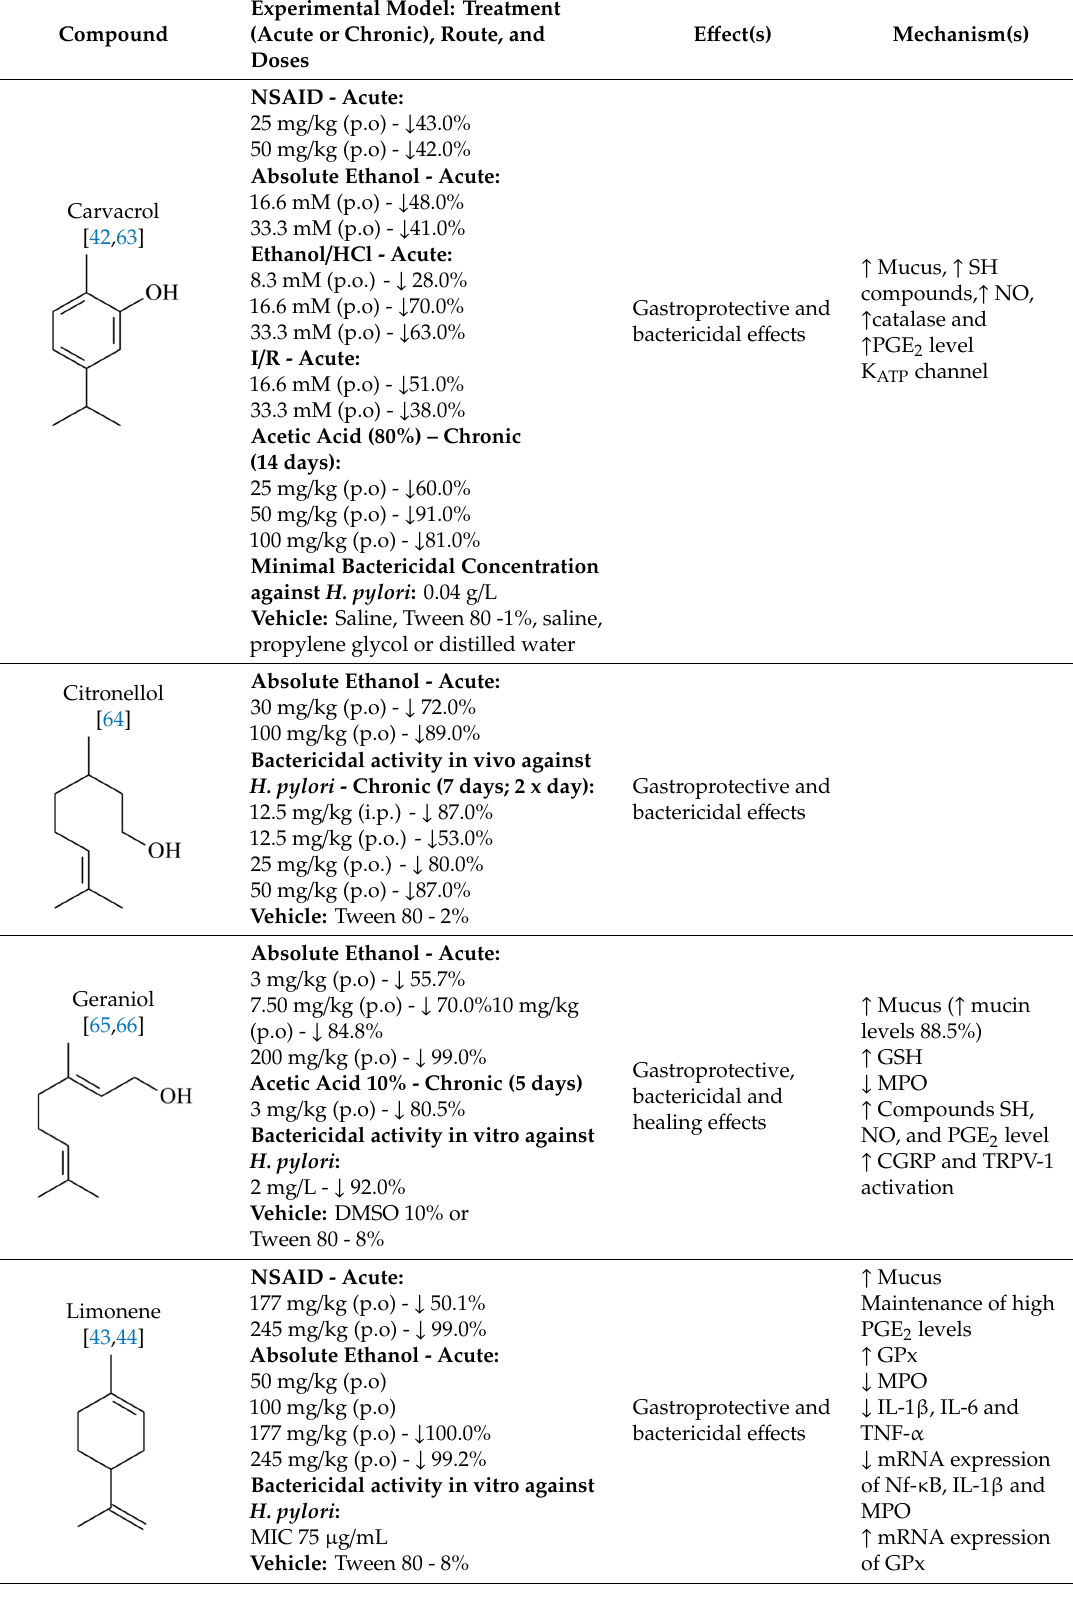
Table 2. Monoterpenes with anti ‐ Helicobacter pylori